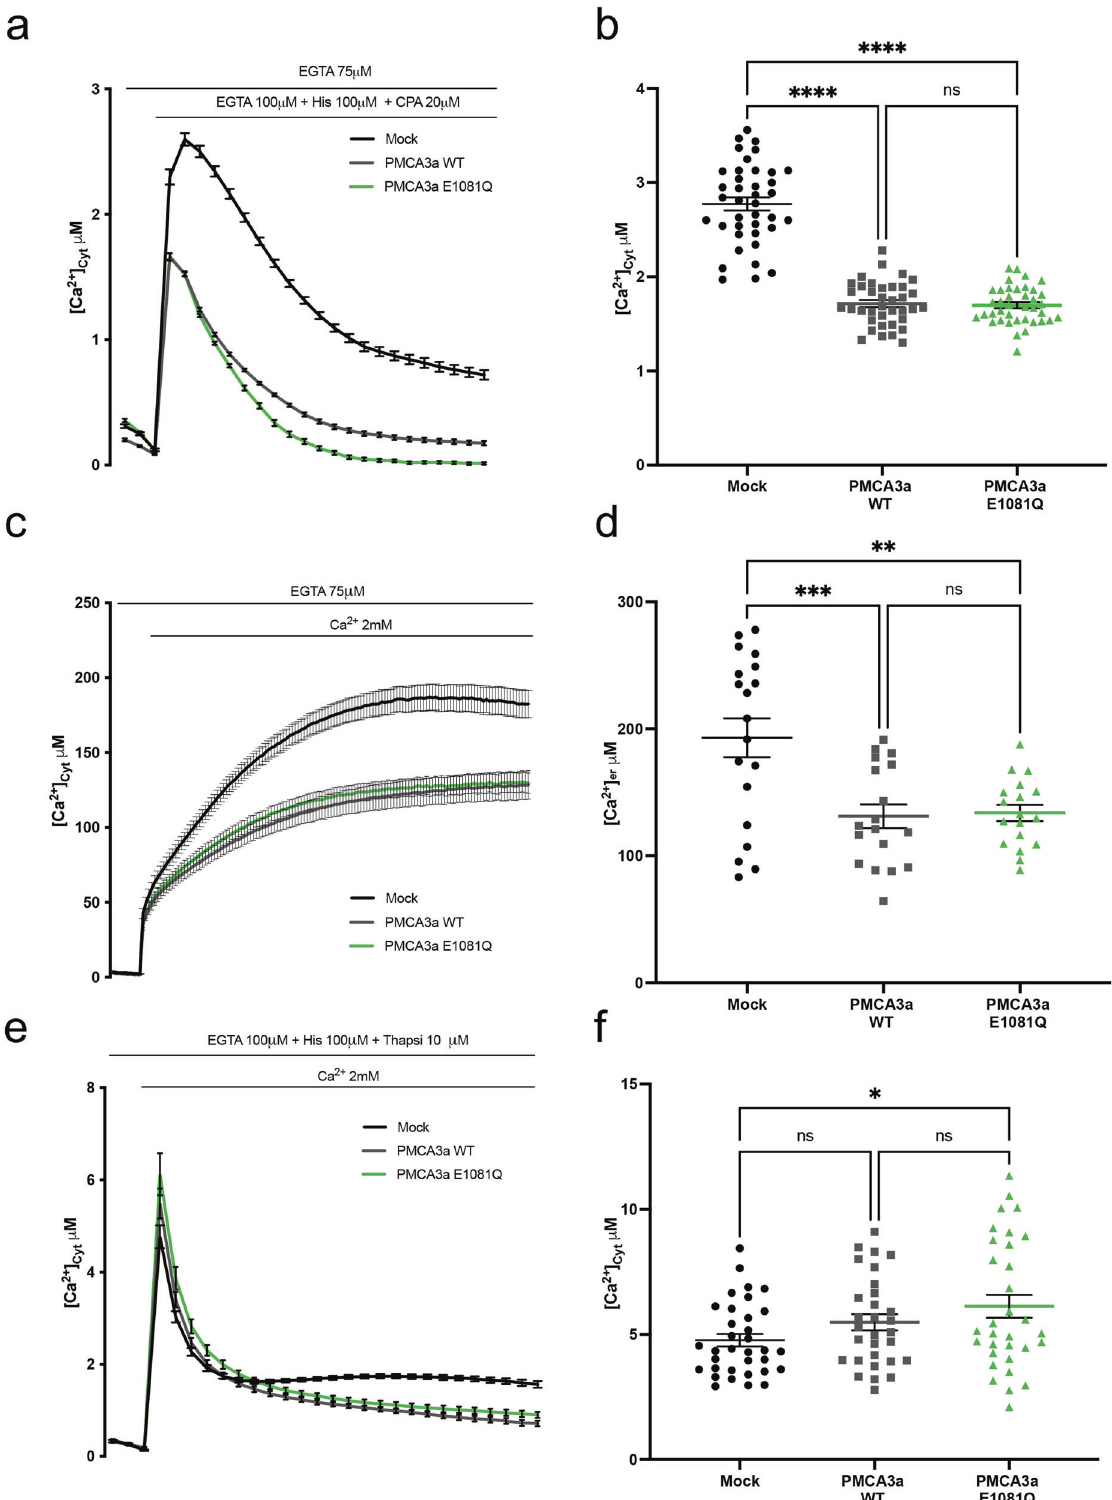
n = 16 for the wt PMCA3 b pump; 149,0 ± 6,81 μ M, n = 15 for the E1081Q PMCA3 b pump); however, it was not different in cells overexpressing the wt or the mutant PMCA3 b pump; suggesting, again, that the mutation does not impinge on the ability of the pump to in fl uence the ER Ca 2 + fi lling or its basal